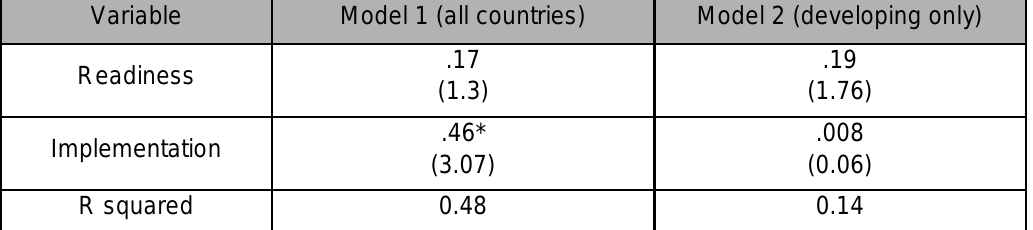
Table 2. Multivariable Linear Regression of Social